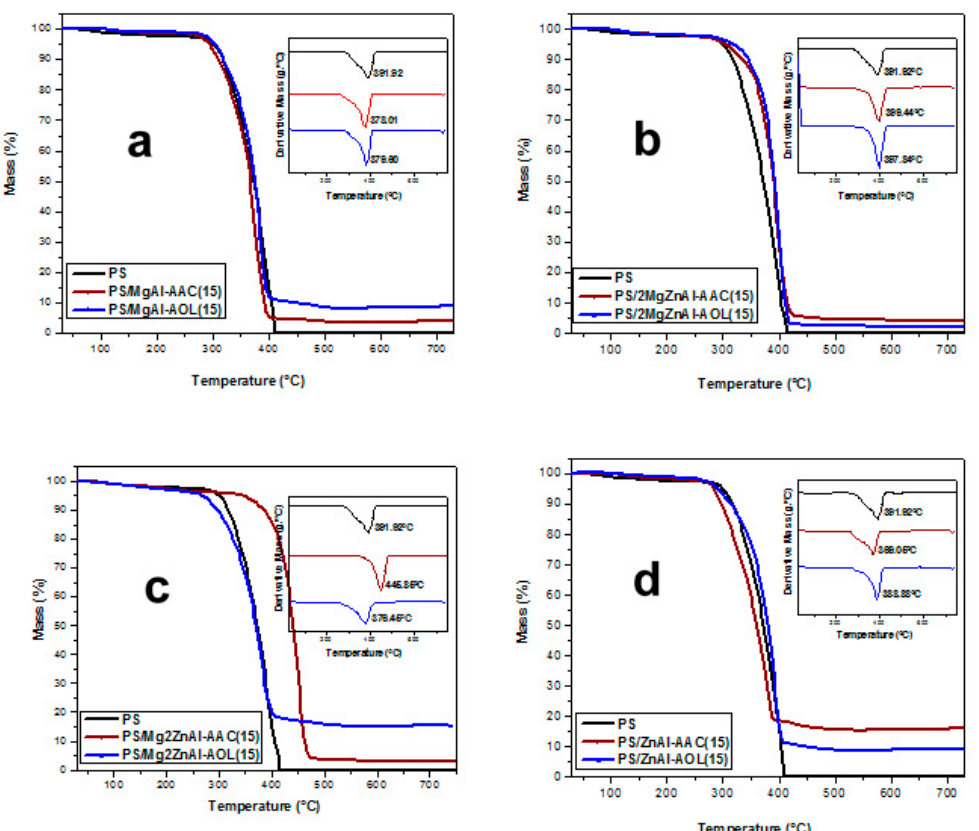
Figure 10. Thermogravimetric analysis for nanocomposites 15 wt.% of LDH modified with acrylate (AAC) and oleate (AOL) anions for: ( a ) MgAl, ( b ) 2MgZnAl, ( c ) Mg2ZnAl, and ( d ) ZnAl.